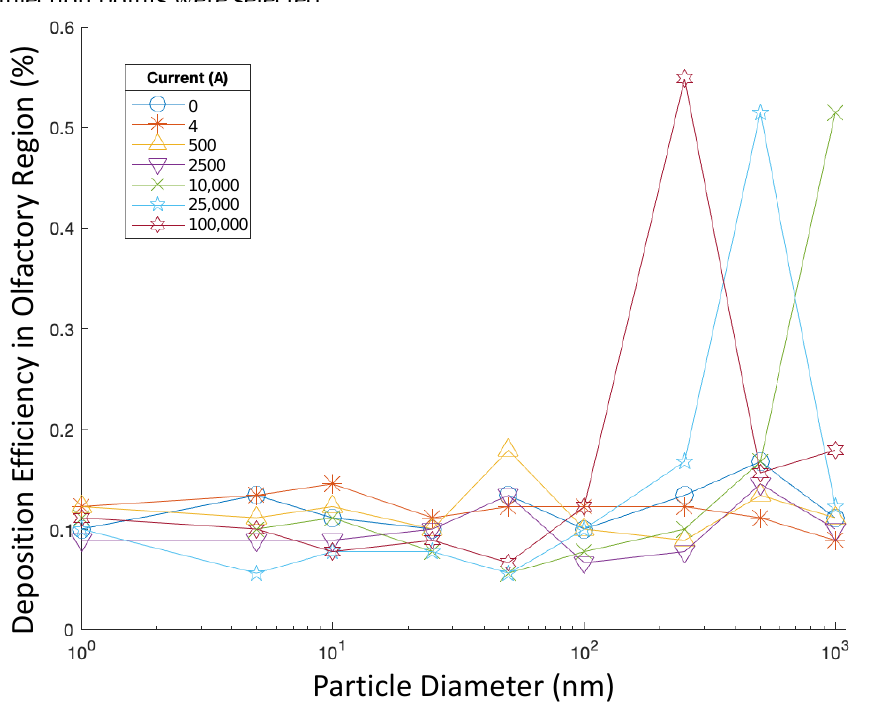
Figure 7. Deposition efficiencies of particles of varying size injected at 5 m/s and in varying magnetic fields.